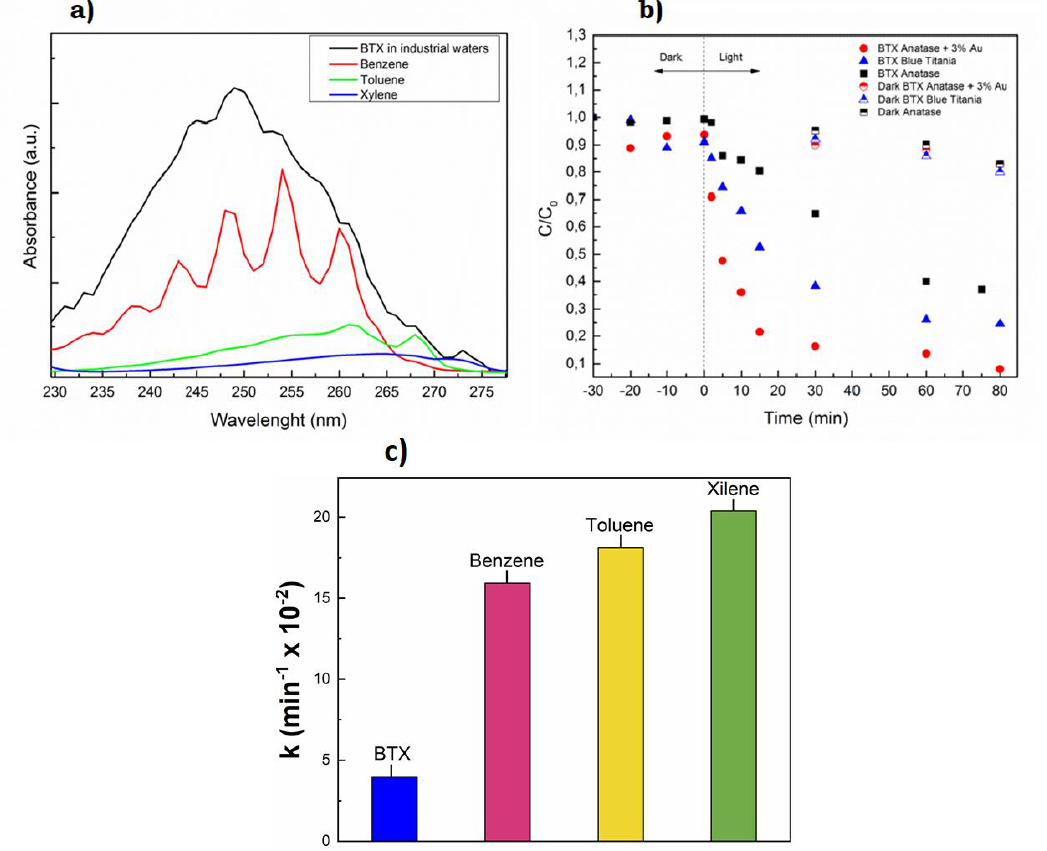
Figure 21. UV–vis spectra of BTX / sulfolane aqueous solution in presence of TiO 2 laser-treated catalyst under solar lamp irradiation ( a ); calculated kinetic constant of the photodegradation for the three catalyst ( b ); kinetic constant for the photodegradation reaction of benzene, toluene and xylene in pure water (10 − 3 M) compared with the BTX mixture in presence of blue Titania catalyst, under solar light irradiation ( c ).